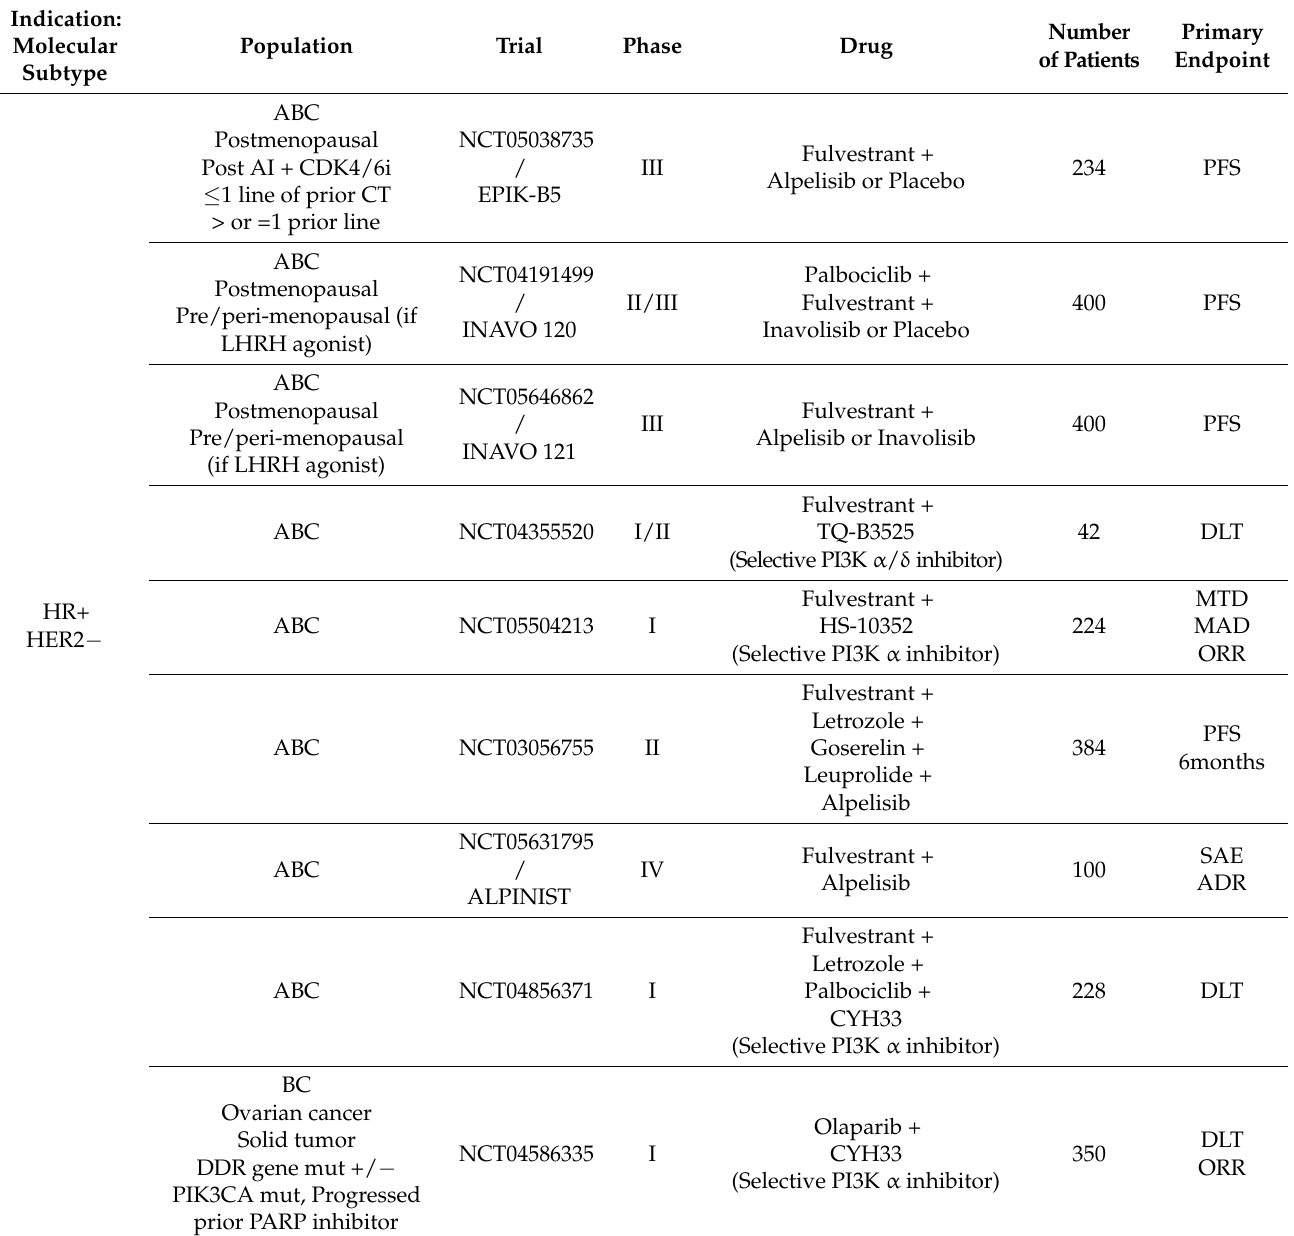
Table 2 summarizes the ongoing trials of PI3K inhibitors in BC. Table 2. Ongoing phase I–III trials of PI3K inhibitors in breast